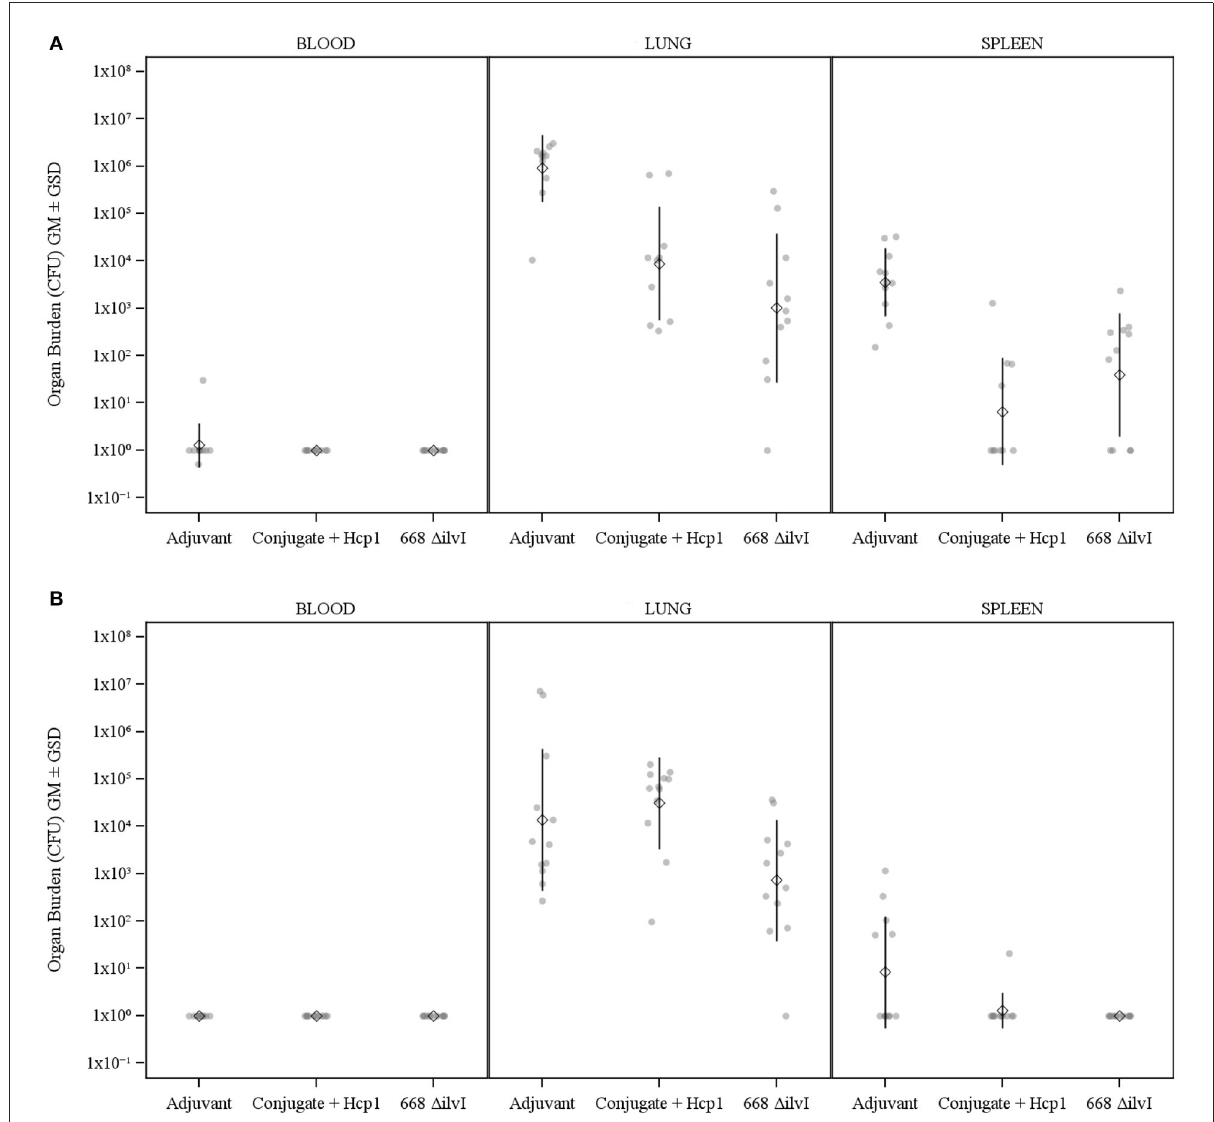
FIGURE6 (A) The recovery of bacteria as determined by CFU counts from blood, spleens and lungs of C57BL/6 mice 3 days post-challenge with Bm FMH. The combined results for both challenges are shown ( n = 10–11 mice/vaccine group). (B) The recovery of bacteria as determined by CFU counts from blood, spleens and lungs of C57BL/6 mice 3 days post-challenge with Bp MSHR5855. The combined results for both challenges are shown ( n = 12 mice/group). The left axis represents CFU/ml (Blood) or CFU/g (Lung and Spleen). The individual points represent one animal, and the baseline points indicate the remaining survivors with no detectable CFU. The diamond-shaped symbol and vertical line are the GM and GSD, respectively. The limits of detection were ∼ 10 CFU/ml (blood) and 5 CFU/g (organs).